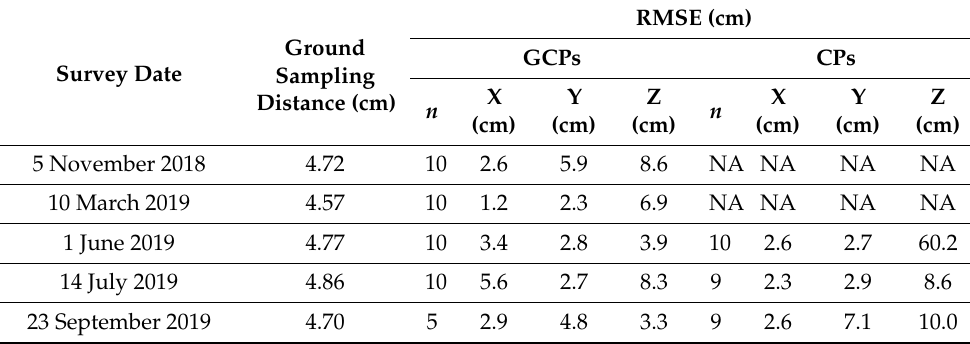
Table 2. Sample size ( n ) and RMSE (x, y and z directions) in geolocation of RGB SfM products for GCPs and